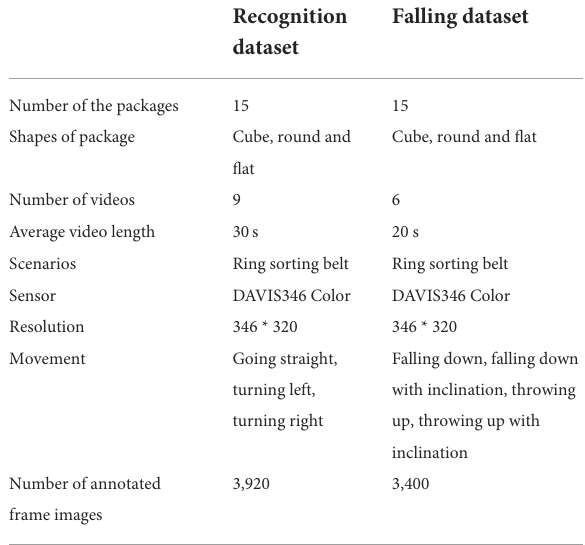
TABLE 2 The experimental settings of two datasets for delivery